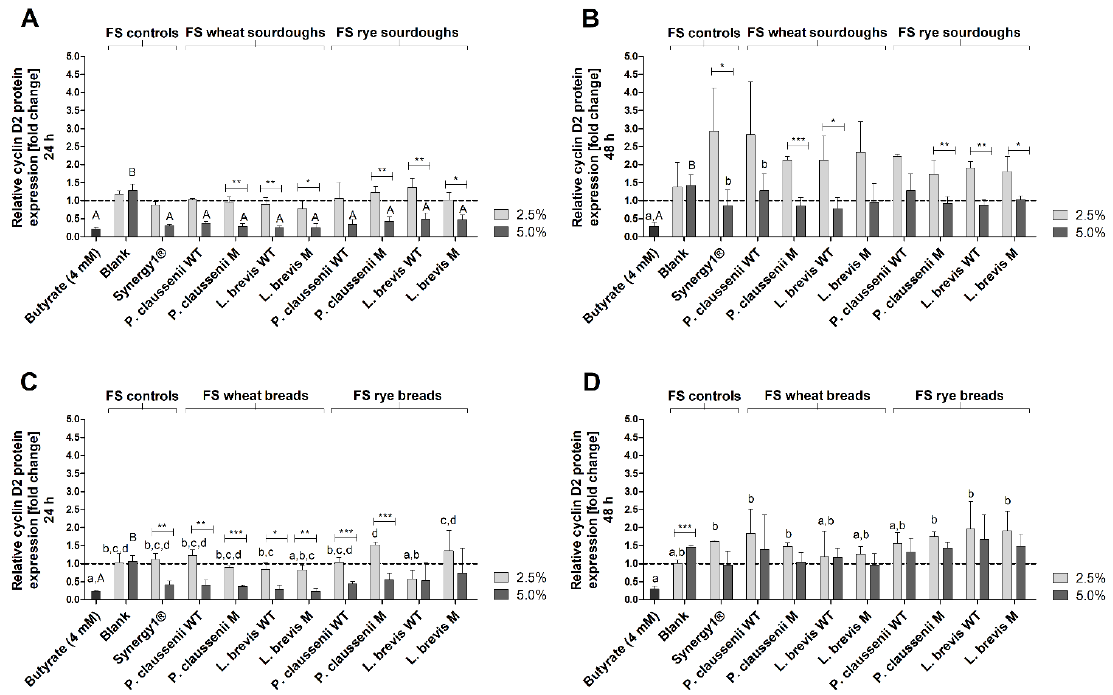
Figure 10. Relative Cyclin D2 protein expression in LT97 cells after treatment with 2.5% and 5% fermentation supernatants (FS) obtained from controls (blank, Synergy1 ® ) and wheat and rye sour- doughs, as well as 4 mM butyrate for 24 h ( A ) and 48 h ( B ) and with FS obtained from controls (blank, Synergy1 ® ) and wheat and rye breads as well as 4 mM butyrate for 24 h ( C ) and 48 h ( D ) (mean + SD, n = 3). Results are presented as fold changes based on a medium control, which was set 1 (dashed line). Sourdoughs and breads were generated using wild-type (WT) and mutant (M) strains of Pediococcus claussenii (WT: TMW 2.340, M: TMW 2.2123) and Levilactobacillus brevis (WT: TMW 1.2112, M: TMW 1.2320). Significant differences between cells treated with 2.5% FS as well as butyrate ( a–d p < 0.05) and 5% FS as well as butyrate ( A,B p < 0.05) were obtained by one-way ANOVA and F-test according to Ryan–Einot–Gabriel–Welsh. Different letters represent significantly different results. Significant differences between cells treated with 2.5% and 5% FS were obtained by unpaired Student’s t -test (* p < 0.05, ** p < 0.01, *** p < 0.001). TMW: Technische Mikrobiologie